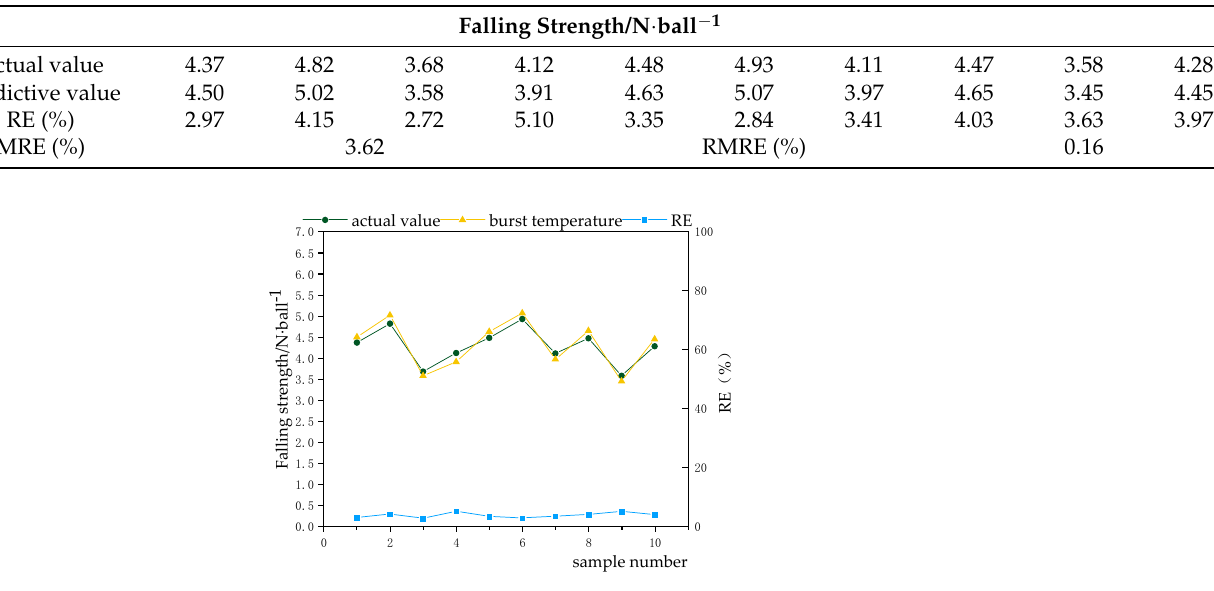
Figure 9. Variation trend of the error of the falling intensity prediction model.